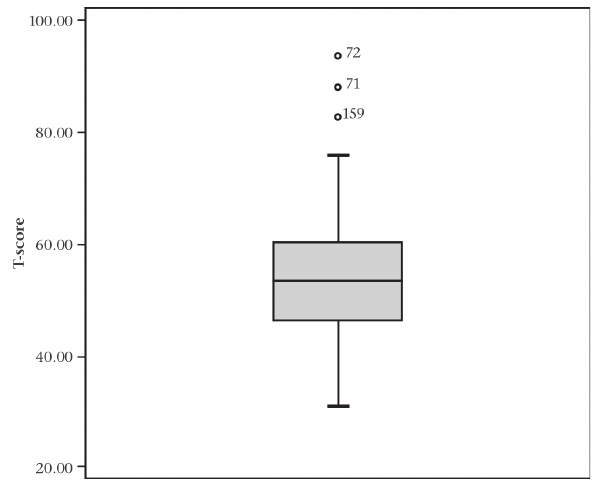
Figure 1: Box-and-whisker diagram of anxiety scores